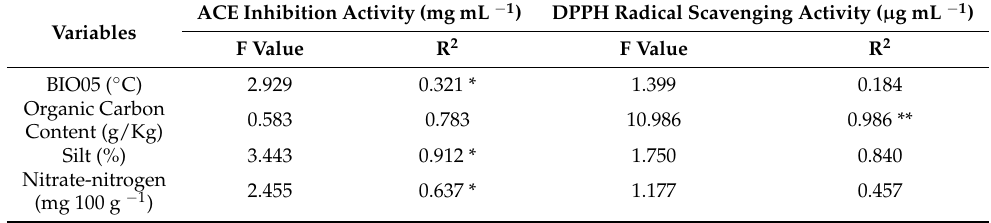
Table 3. ANOVA of effects of variables on ACE inhibition activity and DPPH radical scavenging